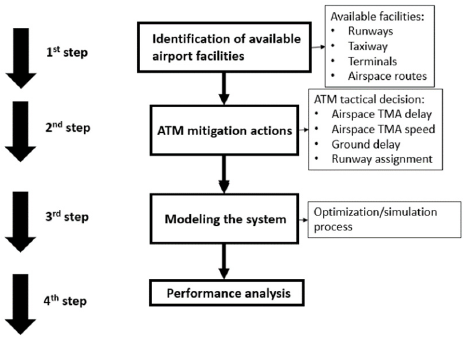
Figure 1. Methodology diagram.